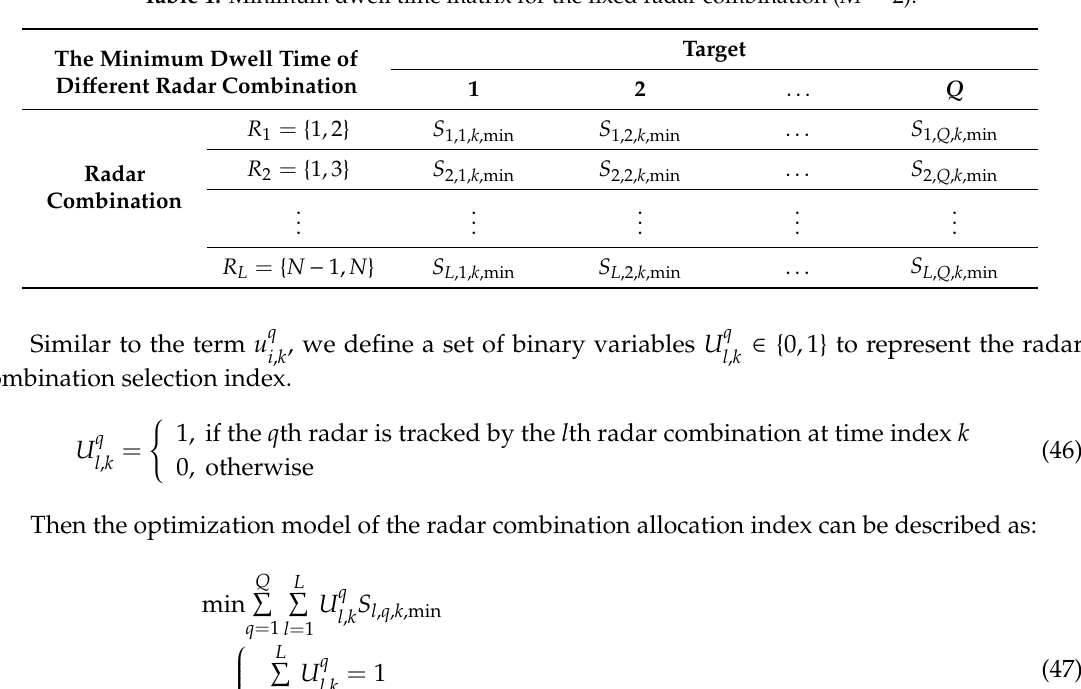
Table 1. Minimum dwell time matrix for the fixed radar combination ( M = 2).